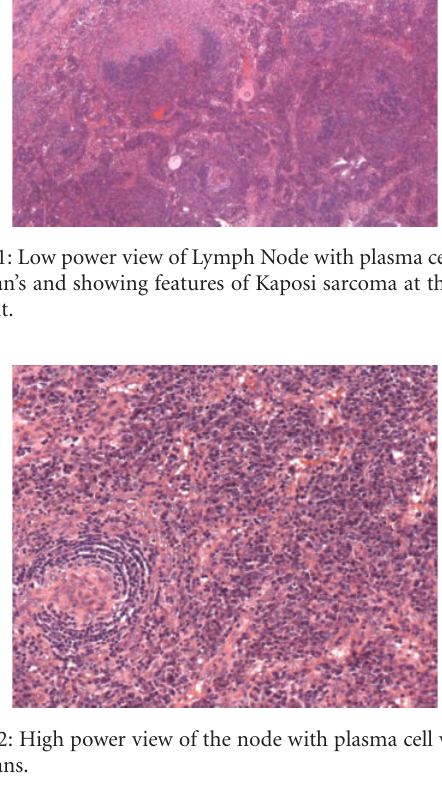
wcc 0.6 IU/l, platelets 97 IU/l, and 0.0 neutrophils! He